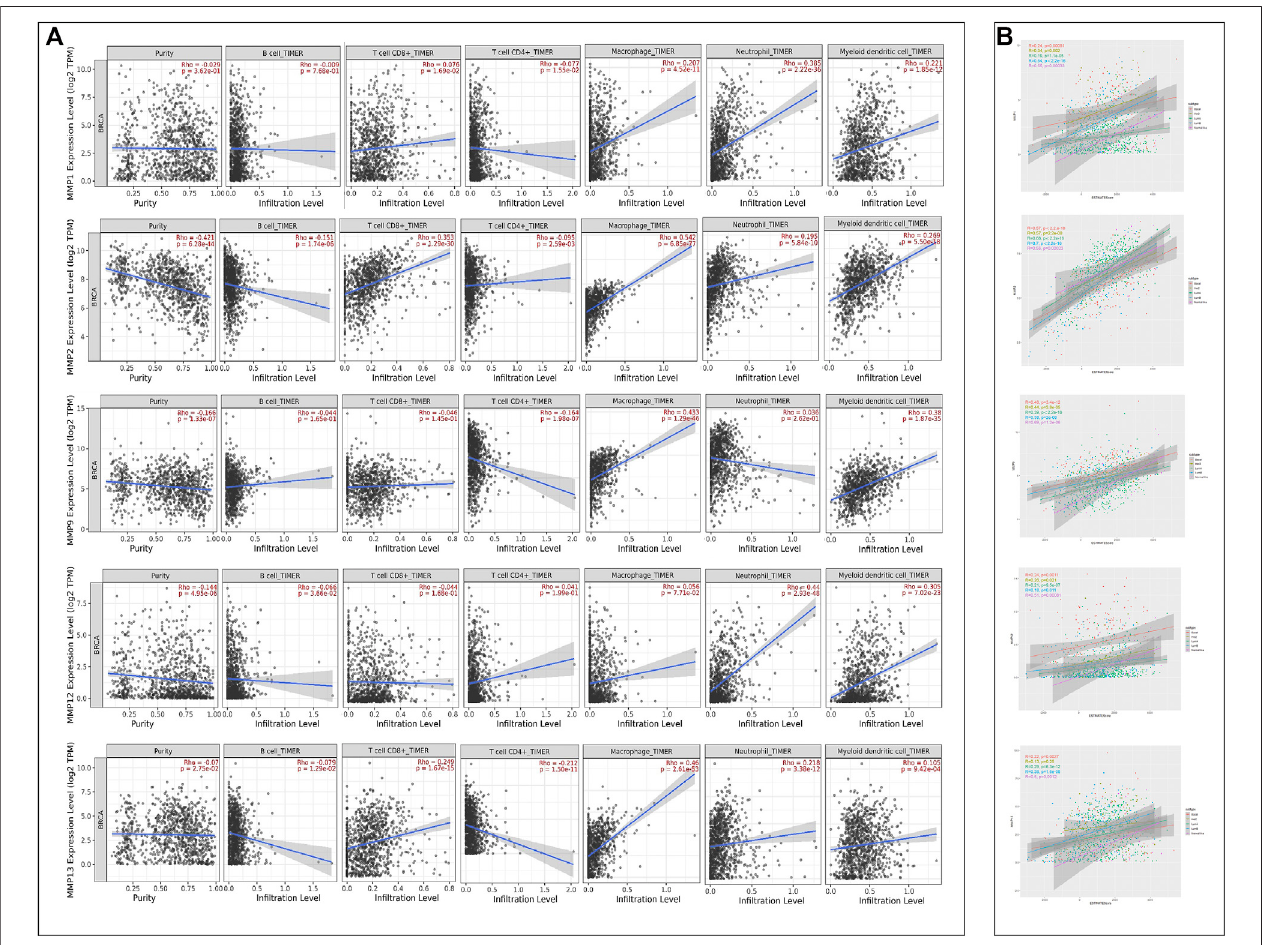
FIGURE8|(A) Correlations between MMPsexpression and immune cell in fi ltration (TIMER). (B) TheESTIMATE ScoresofMMPs. Theexpression levels ofMMP1, MMP2, MMP9, MMP12 and MMP13 in fi ve BRCA subtypes were positively associated with the ESTIMATE Scores.